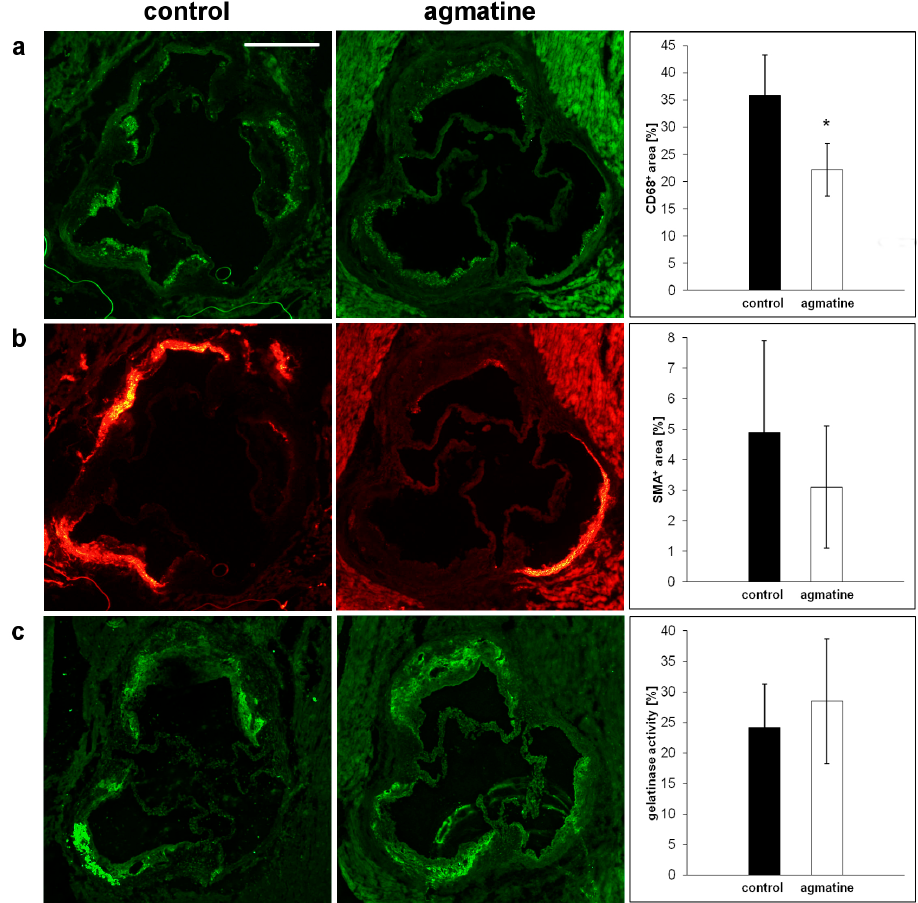
Figure 2. Representative micrographs showing immunohistochemical staining of aortic roots from control and agmatine-treated apoE-knockout mice. The figure shows immunohistochemical visualization and quantitative analysis of CD68-positive macrophages (green) ( a ), smooth muscle α -actin (SMA) - positive cells (red) ( b ), and gelatinase activity (green) ( c ). (* p < 0.05; Mean ± SD). The scale bar represents 500 μ m. Table 1. Plasma lipids level in control and agmatine-treated groups, presented as mean ± SD. TC (mmol/L)